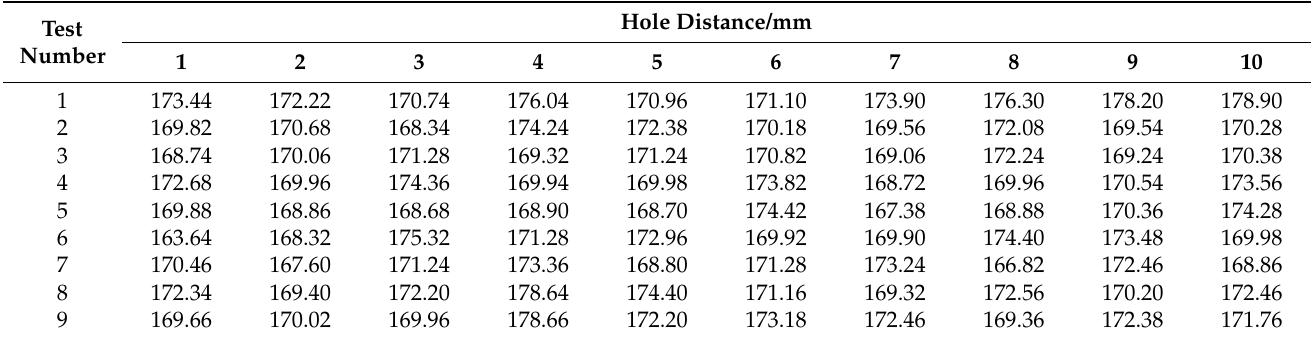
Table 4. Hole distance statistics in bench